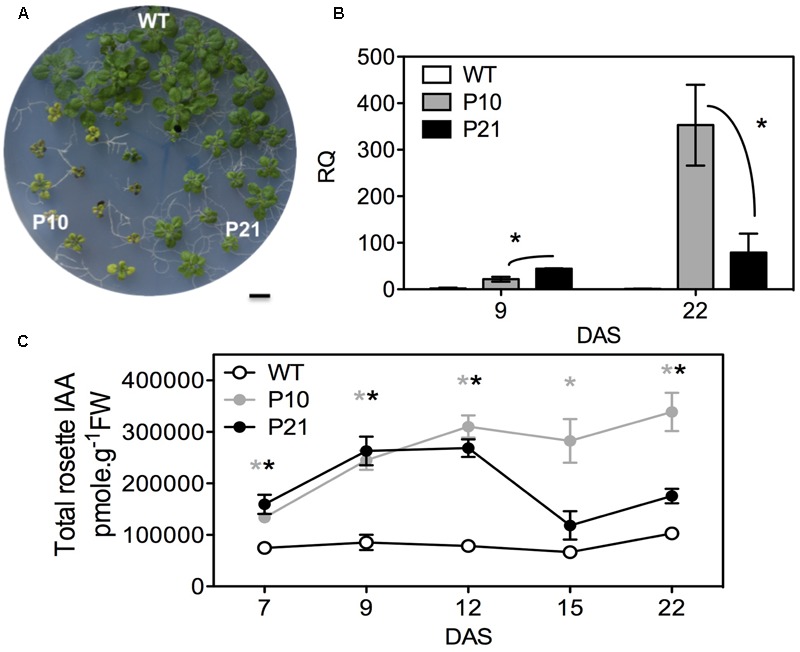
Effect of PID overexpression on rosette phenotype and auxin pool in the whole rosettes. Rosette phenotypes of WT and two PIDOE lines, P10 and P21, at 22 DAS (A). Relative quantification (RQ) of PID transcript in the leaves of WT, P10, and P21 at two different time points, n = 3; Asterisks mark the significant differences between the PID overexpression (PIDOE) lines (B). Total auxin (indole-3-acetic acid; IAA) measurements in the rosettes (C). The averages and standard error of relative expression are based on three biological replicates. Gray and black asterisks represent significant differences toward WT, for P10 and P21, respectively. DAS, days after stratification. Error bars: ±SE (t-test P < 0.05). Scale bar = 10 mm.